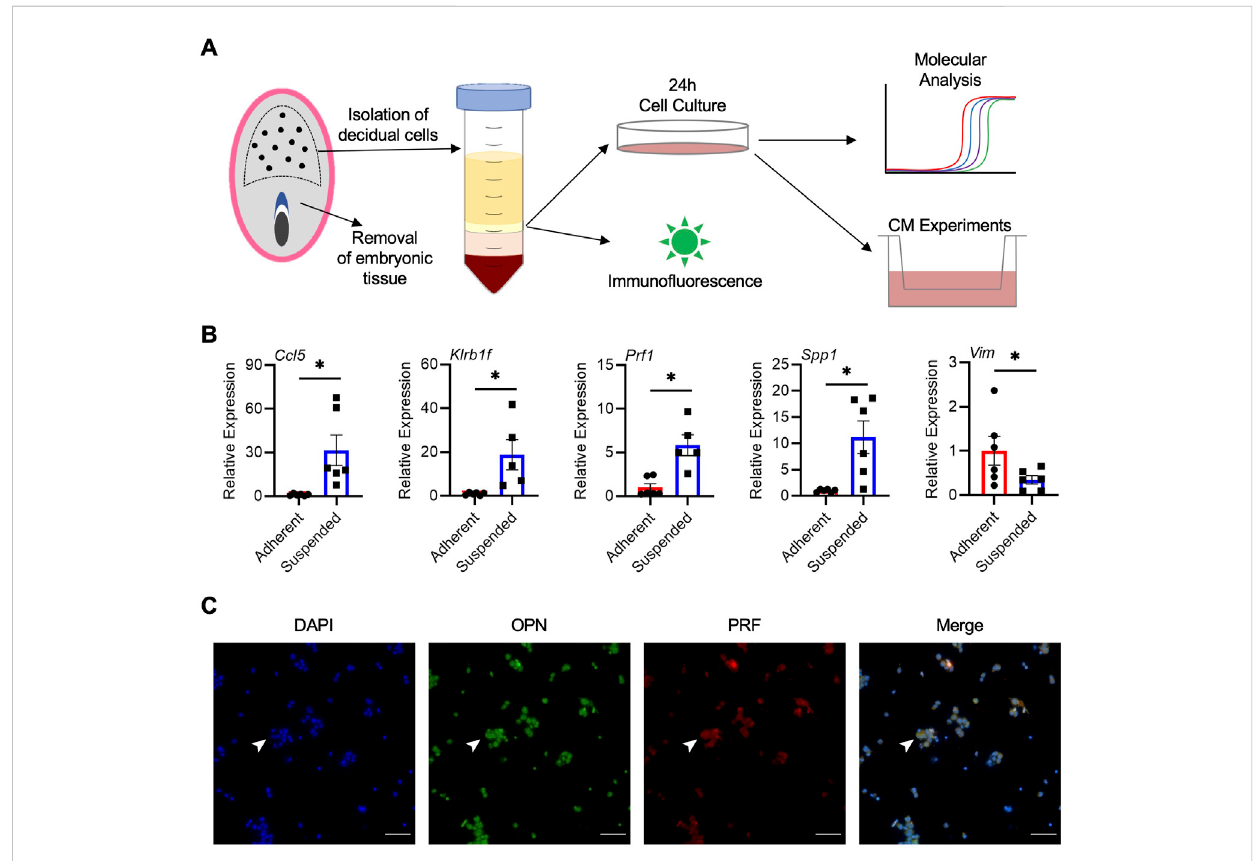
Isolation and enrichment of Spp1 -expressing NK cells from the rat decidua. (A) Schematic depiction of experimental protocol. (B) Relative gene expression of Ccl5 , Klrb1f , Prf1 , Spp1 , and Vim in adherent and suspended cells isolated from GD 9.5 decidua and cocultured for 24 h. Experiments were performed 6 times using different dams. (C) Non-adherent cells isolated from GD 9.5 decidua express both PRF and OPN. Arrowheads indicate a representative cell positive for both PRF and OPN staining. Scale bars, 50 μ m. Results represent means ± SEM. Data signi fi cantly different from controls ( p < 0.05; Student ’ s t -test) are indicated by an asterisk